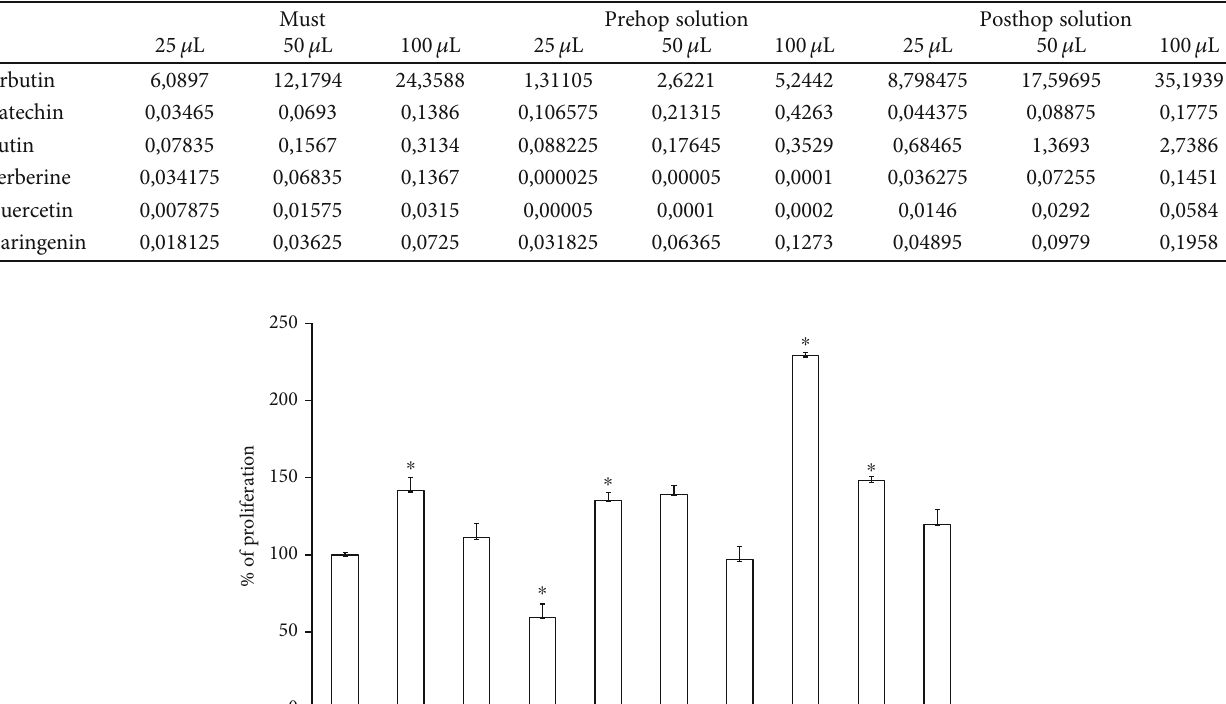
Table 2: It is shown the corresponding concentration of polyphenols in the tested volume expressed in μ g/ μ L. The calibration curve was constructed employing dependence between peak areas and concentration, using the mean values of three determinations for each concentration.